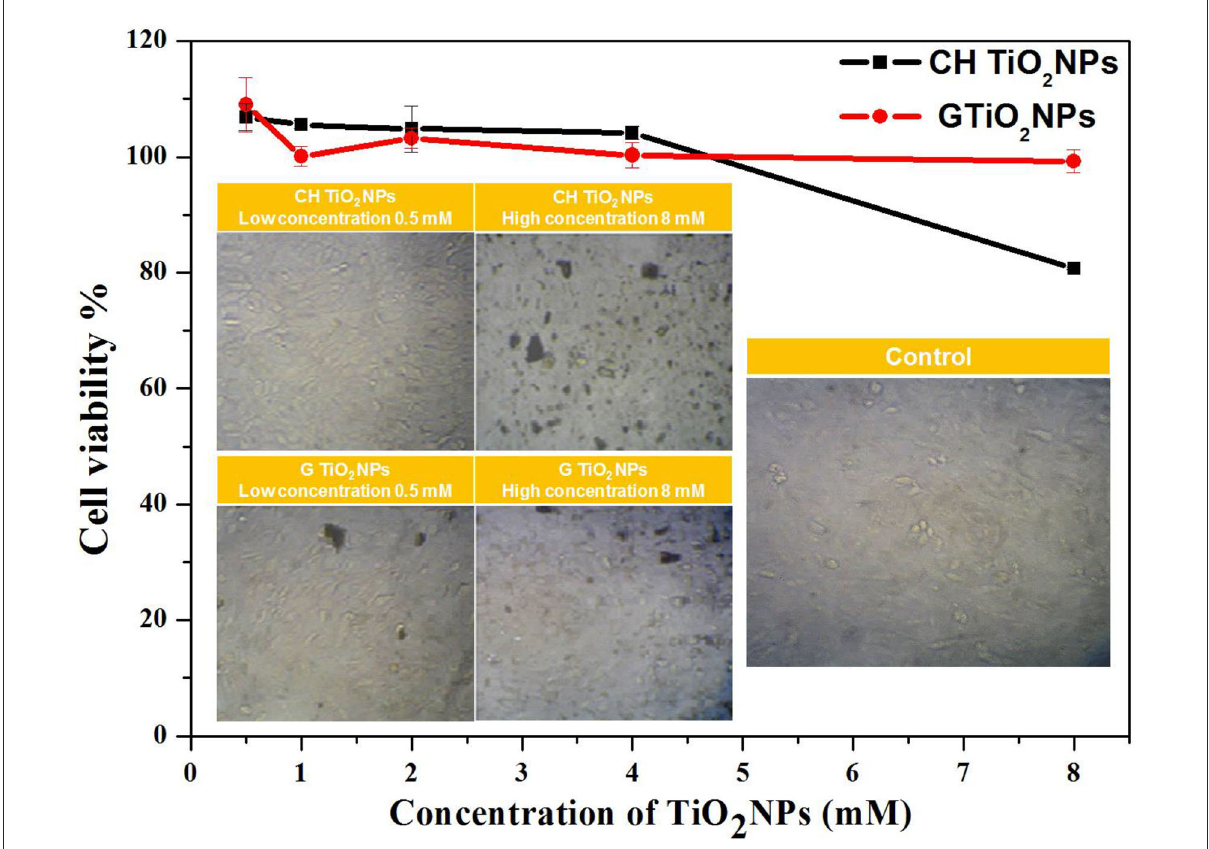
FIGURE2 Cell viability of HepG 2 cells after 24h exposure to CHTiO 2 NPs and GTiO 2 NPs with different concentrations and microscopic images of HepG 2 cells after 24 hrs of exposure to CHTiO 2 NPs and GTiO 2 NPs at concentration 0.5mM and